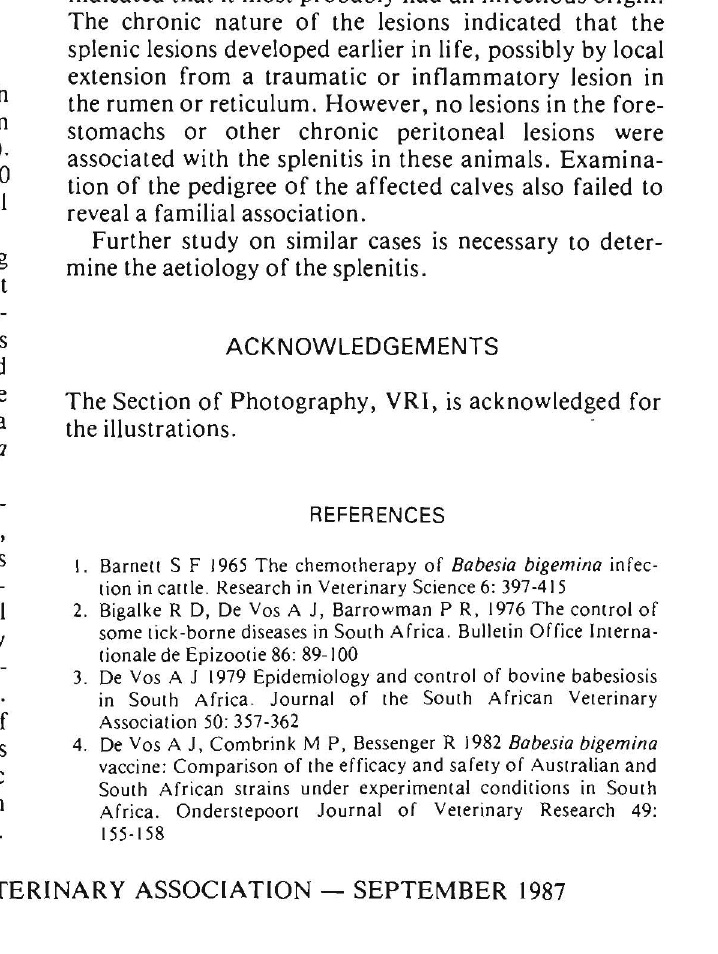
Fig. 3: Thickened trabecula (T) infiltrated by inflammatory cells. Focus of necrosis (arrow) in red pulp. HE X 200